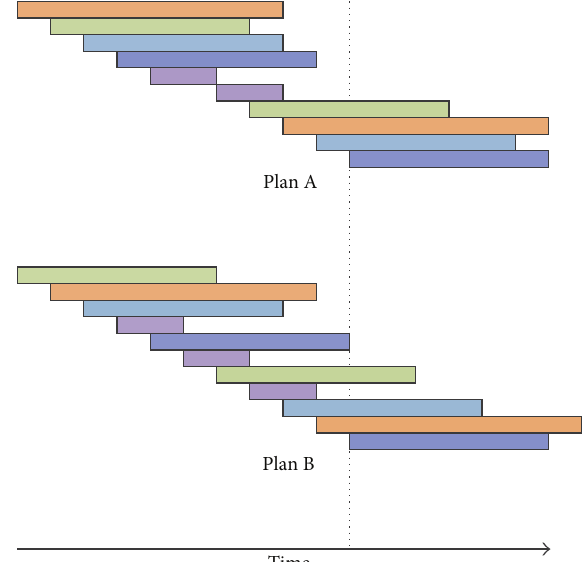
Figure 7: Ability planning using a burst strategy (Plan A) and a DPS strategy(PlanB).Rectanglesrepresentcooldownperiodsofabilities. Each color corresponds to a different ability. Cast time is represented by a delay between the use of two consecutive